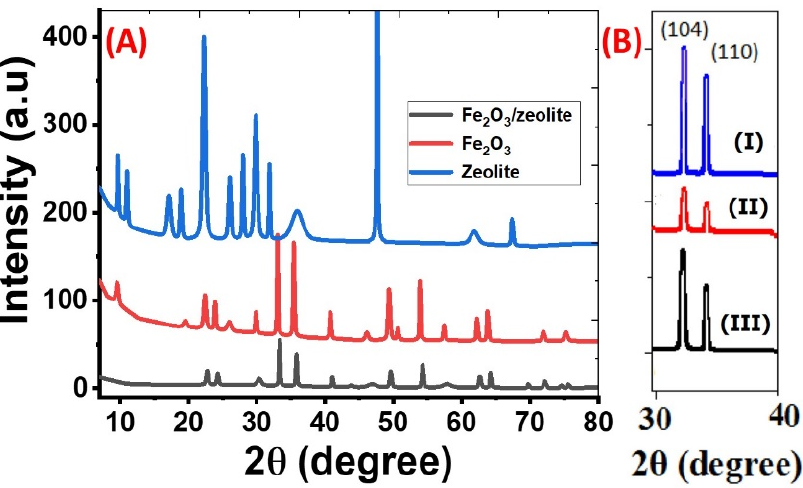
Figure 2. ( A ) XRD patterns of zeolite, Fe 2 O 3 , and Fe 2 O 3 /zeolite nanocomposite; and ( B ) XRD (104) and (110) peaks of Fe 2 O 3 (I), Fe 2 O 3 (II), and Fe 2 O 3 (III). For zeolite, many distinct peaks are observed at 22.72 ◦ (101), 41.05 ◦ (210), and 54.24 ◦ (221), corresponding to tetragonal zeolite (Al 0.05 Si 0.95 O 2 ) according to card No.